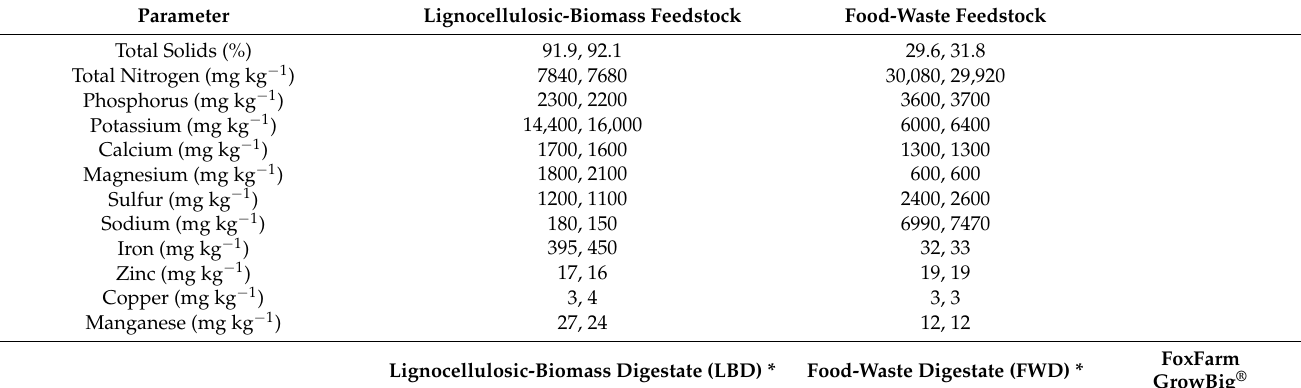
Table 1. Selected chemical characteristics of the feedstocks, digestates and fertilizer used in this study. Feedstock and digestate parameters were measured in duplicate, and both measurements are included, while the values for the commercial FoxFarm product came from the manufacturer’s label. Nutrient values for the feedstocks are on a dry-weight basis, and measurements for digestates are on a wet-weight basis.